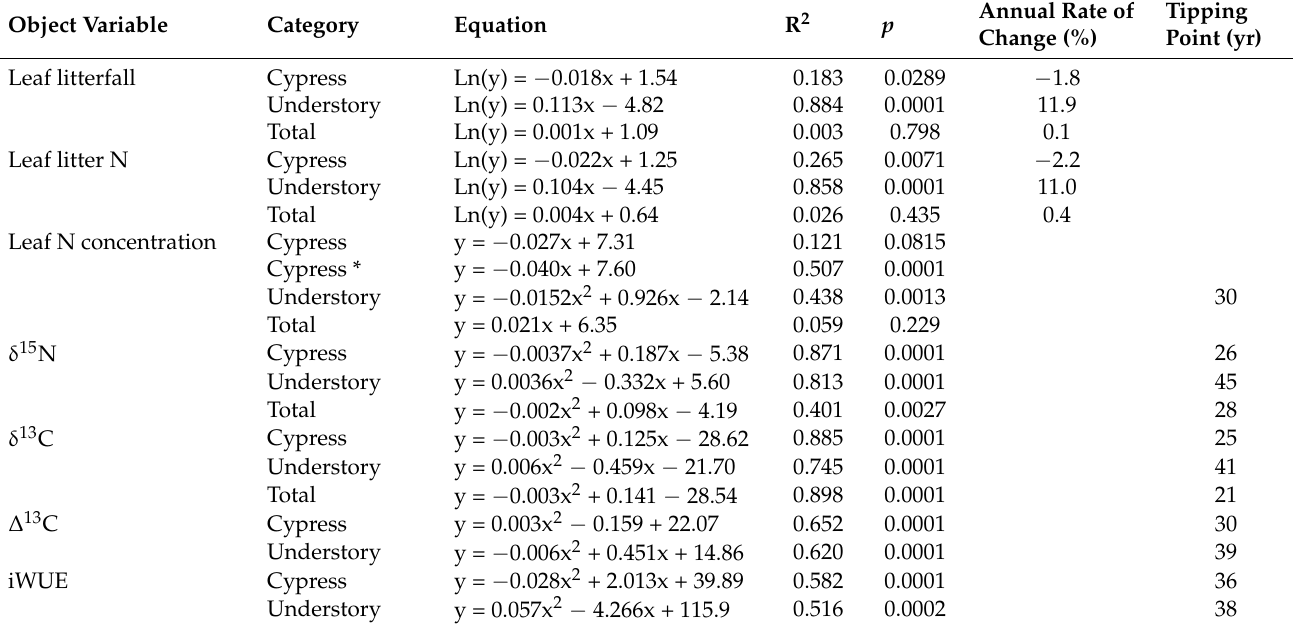
Table 4. Linear and quadric models predicting litter properties. Forest age is used as an explanatory